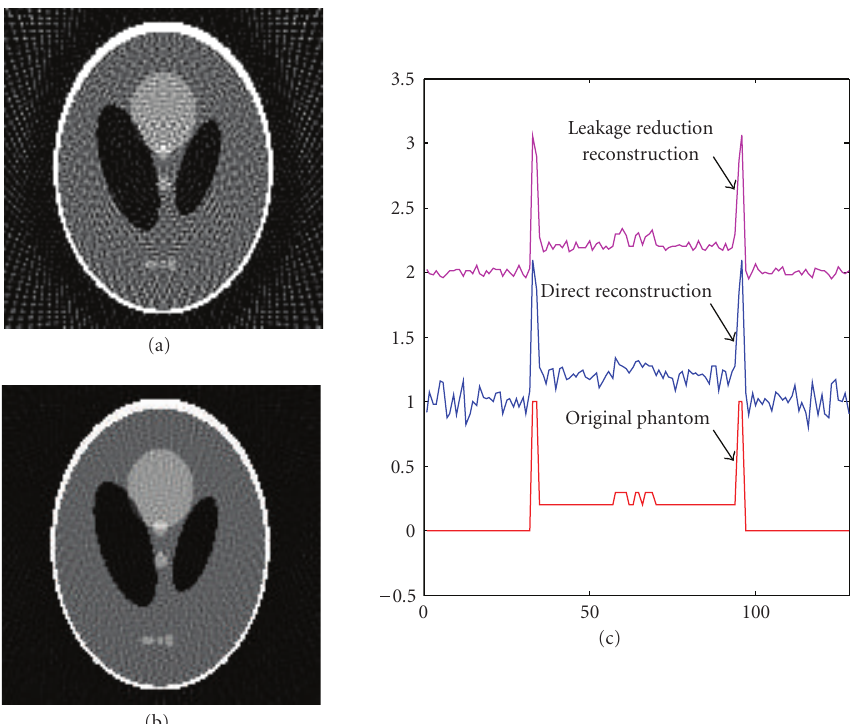
Figure 6: 128 × 128 phantom reconstruction from 70% undersampled radial k -space data with (a) direct reconstruction and (b) leakage reduction reconstruction. (c) Line profiles across the three tiny ellipses.